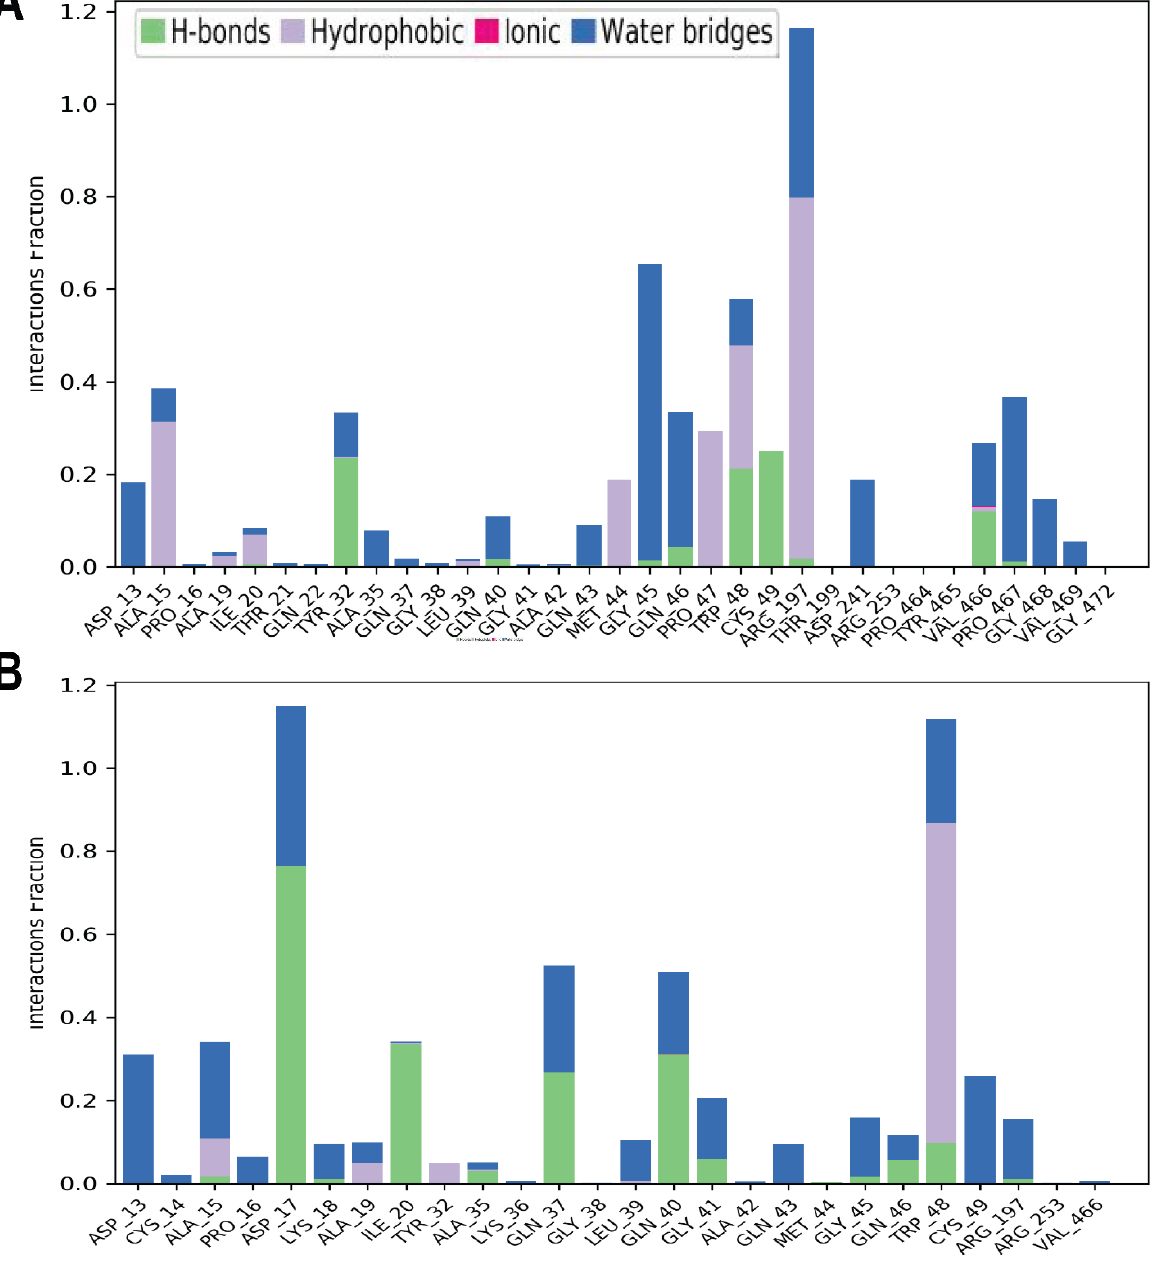
Figure 13. ( A ) Summary of all contacts of α -glucosidase and Trabectedin ( B ) all contacts of α -glucosidase and Demeclocycline during MD simulations.